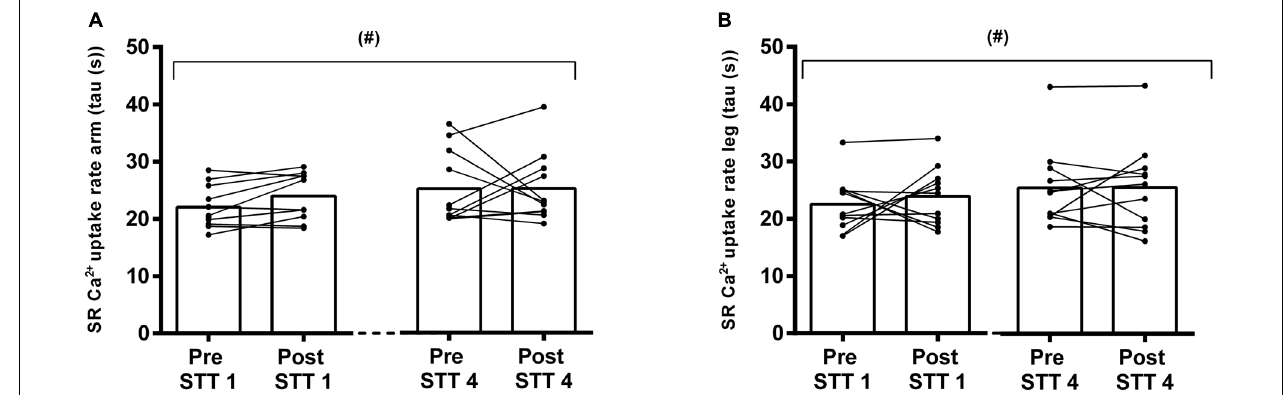
FIGURE 4 | SR Ca 2 + uptake measured as the time for free [Ca 2 + ] to decrease by 63% in arms (A) and legs (B) of elite cross country skiers before (Pre) and after (Post) the first (STT 1, n = 10) and the fourth (STT 4, n = 11) bouts of 1300 m high-intensity skiing. Each bout was interspersed with 45 min of recovery including carbohydrate intake. Both individual changes and mean values are shown; (#) tendency to a main effect of time, P =